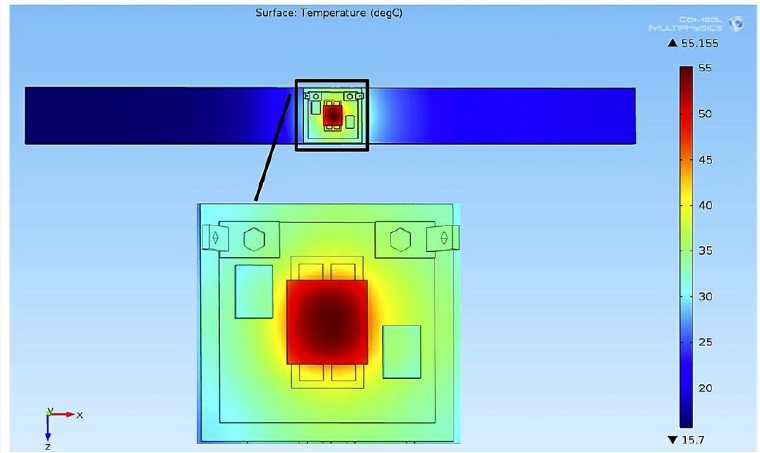
Figure 19. PV temperature profile for active cooling case at 16.9 °C ambient temperature and water inlet temperature of 15.7 °C [72].